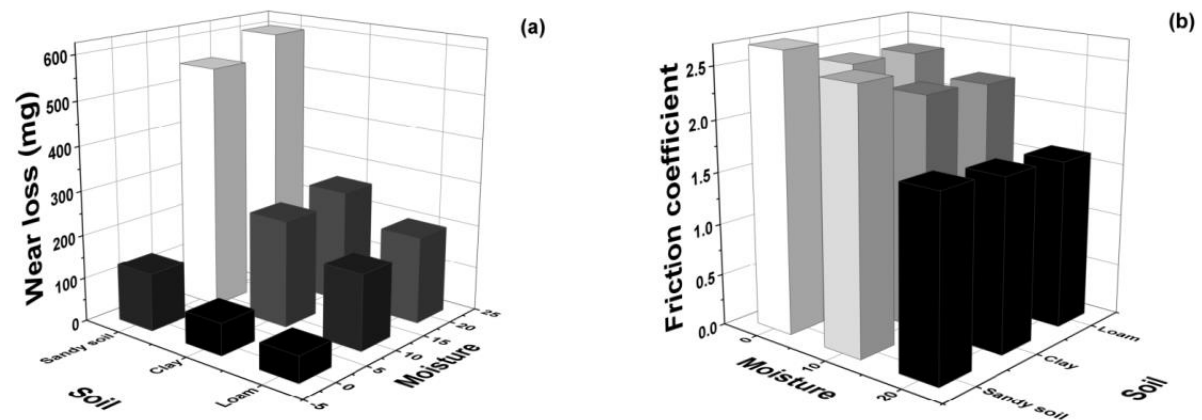
Figure 6. Variations of wear loss and friction coefficient with the sliding distance under different moisture and soils (450 r/min, 5 N): ( a ) wear loss and ( b ) friction coefficient.